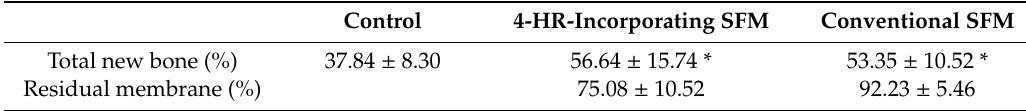
Table 1. Histomorphometric analysis. Reproduced with permission from Lee, S. W. [41].